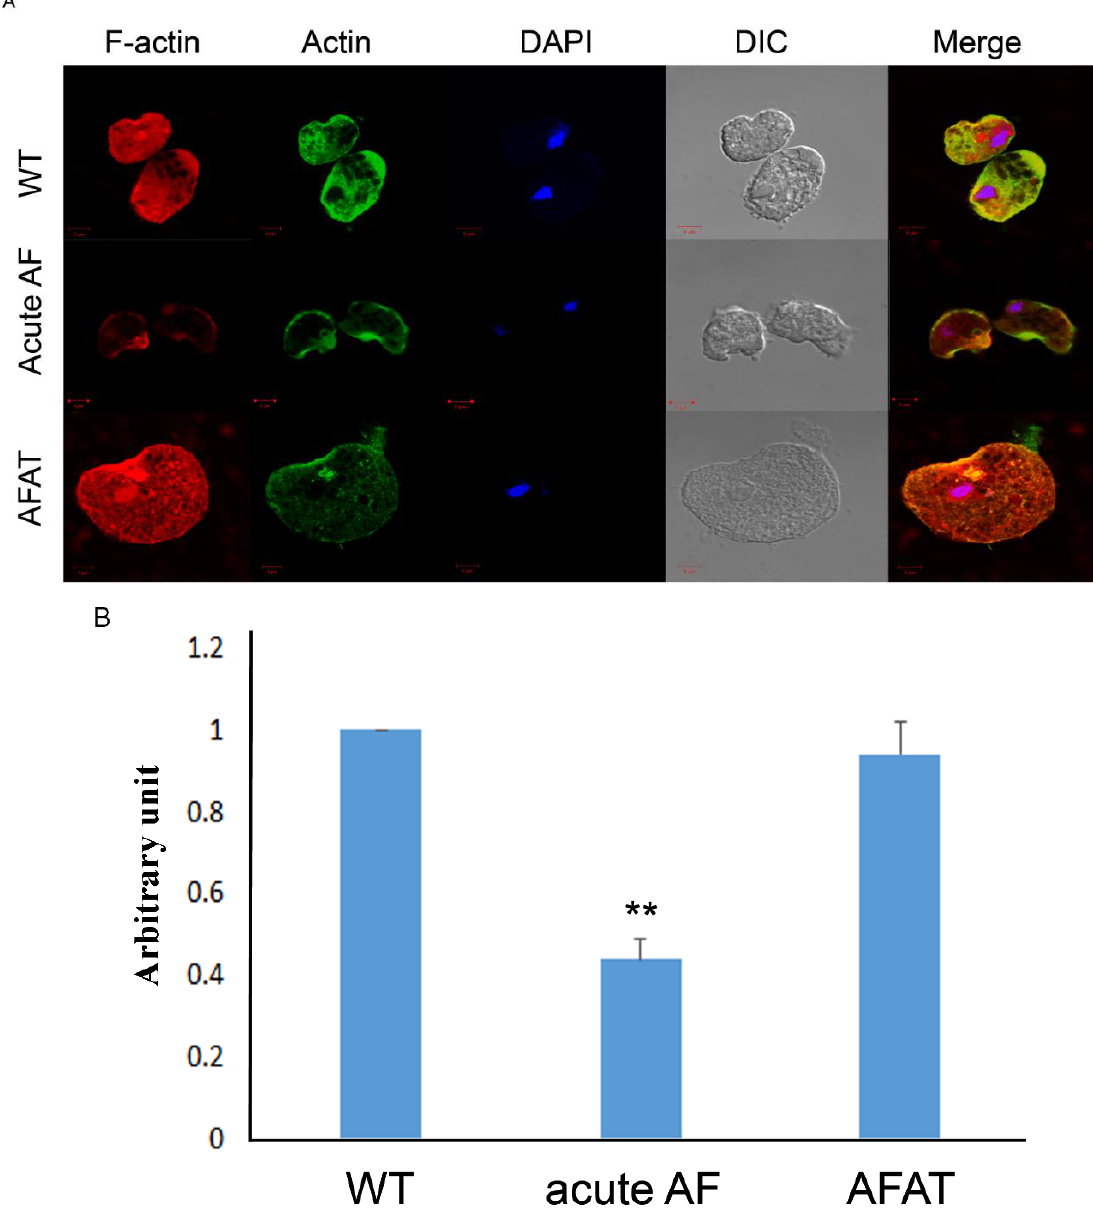
Figure 5. Formation of F-actin in WT trophozoites, acute AF trophozoites, and AFAT. ( A ) Confocal laser scanning microscopy of F-actin and total actin in WT trophozoites, acute AF trophozoites, and AFAT showed that F-actin was detected using rhodamine-conjugated phalloidin. Total actin was detected using a primary actin antibody and a secondary Cy2-conjugated immunoglobulin G (IgG) antibody. The nuclei (blue) were stained by 4′,6-diamidino-2-phenylindole (DAPI). ( B ) A computer-assisted image was overlaid on the signal emitted by the actin antibody, phalloidin, and DAPI. Fluorescence quantification was performed using Fiji software [38] on 10 trophozoites and the F-actin signal was normalized to the total actin signal. The level of F-actin in WT was arbitrary defined as 1. Data are expressed as the mean ± standard deviation of two independent experiments. The level of F-actin in acute AF trophozoites was significantly different from that in WT and AFAT according to the results of an unpaired Student’s t test (** p value < 0.01). No difference of F-actin level between WT and AFAT was observed according to the results of an unpaired Student’s t test ( p value > 0.05).